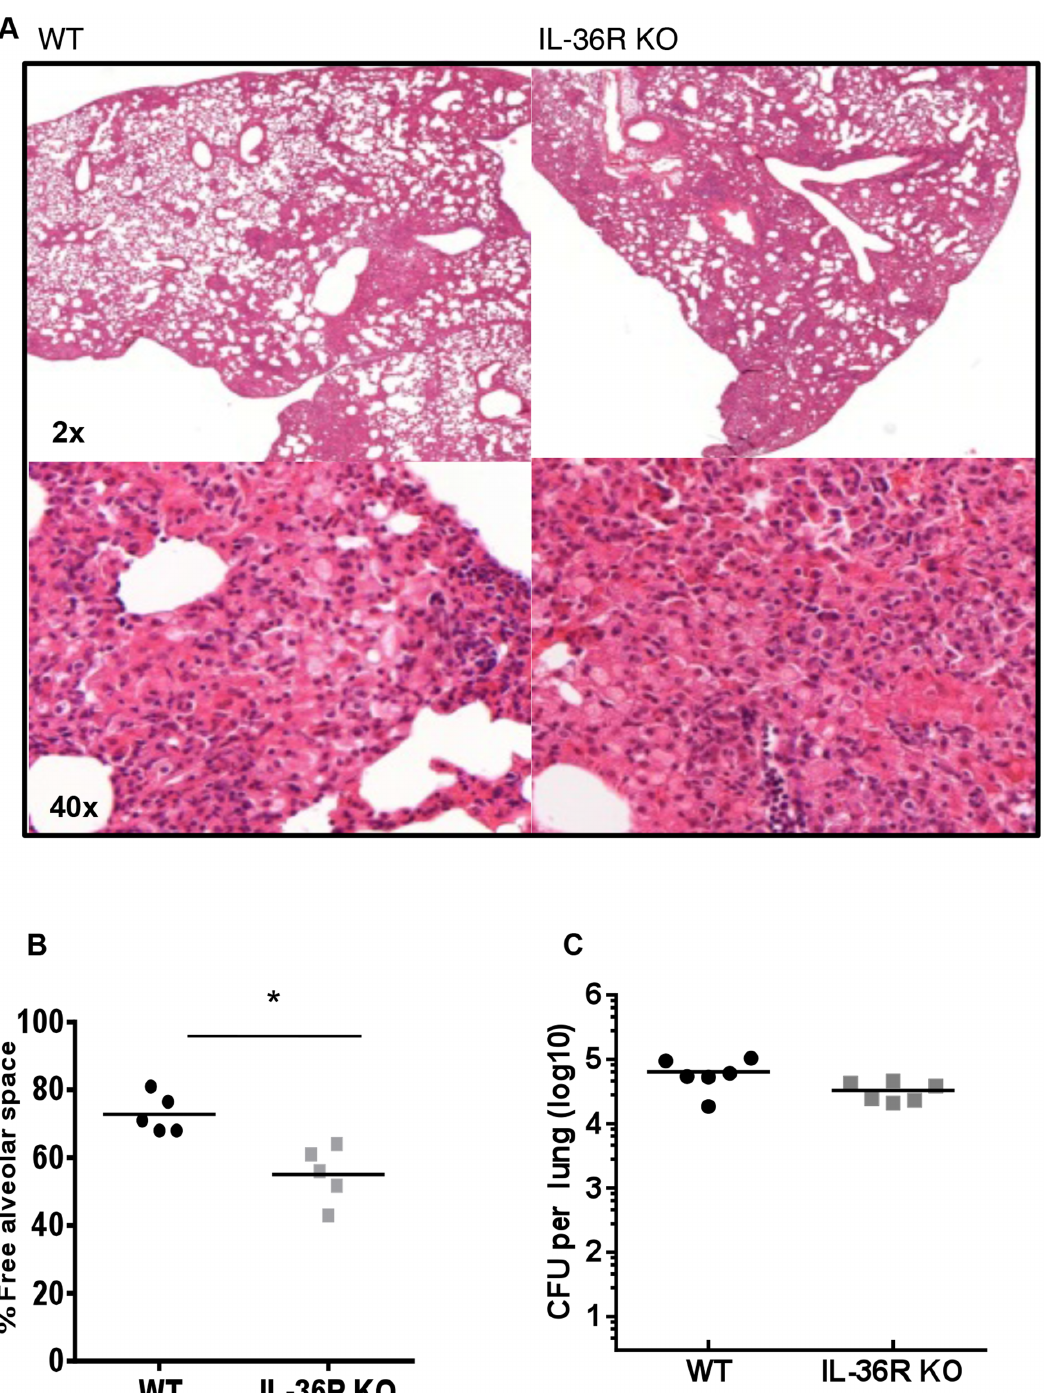
Fig 5. Histopathology and bacterial loads in wild-type and IL-36R deficient mice. Hematoxylin eosin staining of lung sections 4 weeks after M . bovis BCG infection of WT (left panels) and IL-36R deficient (right panels) mice (original magnifications X2, upper panel, and X40, lower panel) (A). Determination of free alveolar space on lung sections. Data are represented as the mean ± SD of percentage of lung lesion free/total lung tissue in 5 mice per group with 1 or 2 lobes analyzed per mouse (B). Lung bacterial loads at 4 weeks post-infection are represented as CFU per lung (n = 6 mice per group) (C). ** P < 0.01 as assessed by Mann Whitney